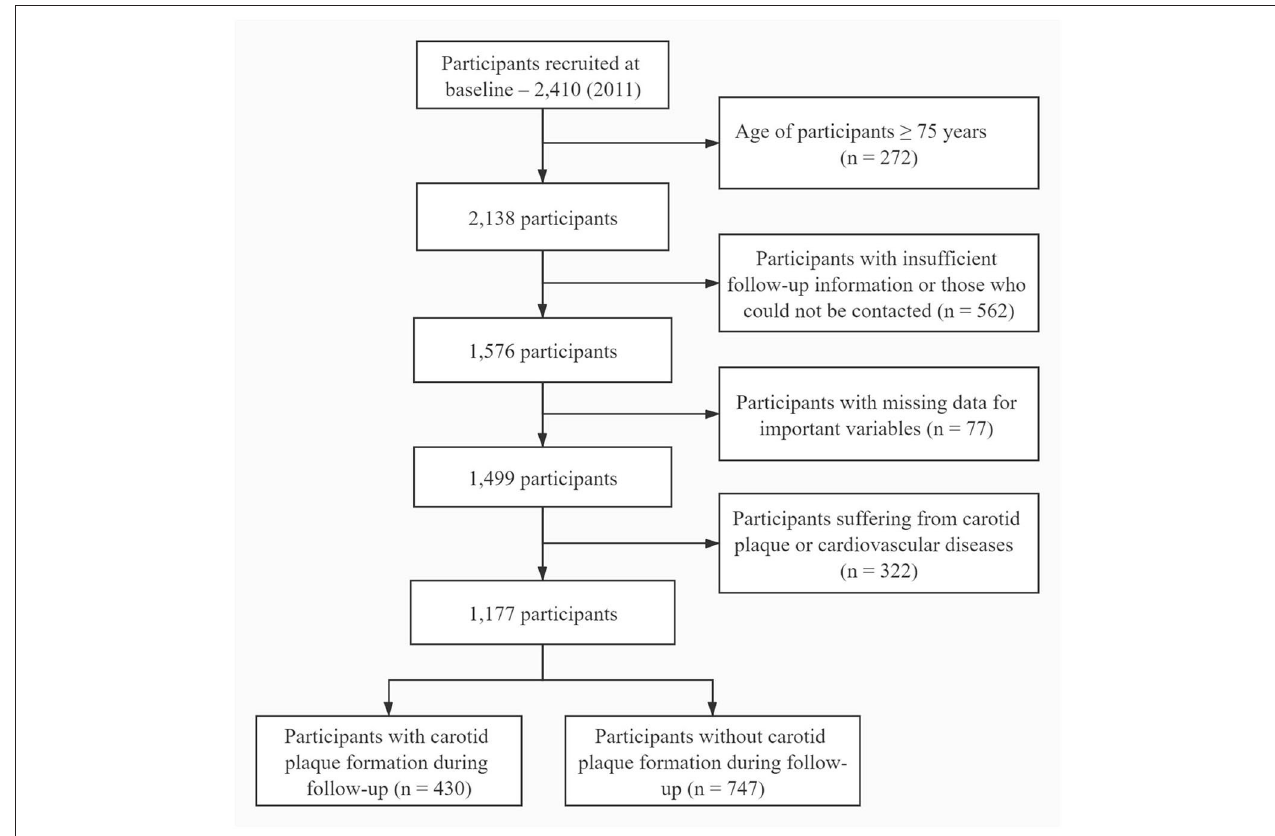
FIGURE 1 | Flowchart depicting participant enrollment. Subjects who were between 35 and 74 years of age and had a full follow-up information were eligible for enrollment in the study. Participant aged 75 years or older were excluded ( n = 272). All subjects who had insufficient follow-up information ( n = 562), missing data ( n = 77), or suffering from cardiovascular diseases or carotid plaque ( n = 322) at baseline were also